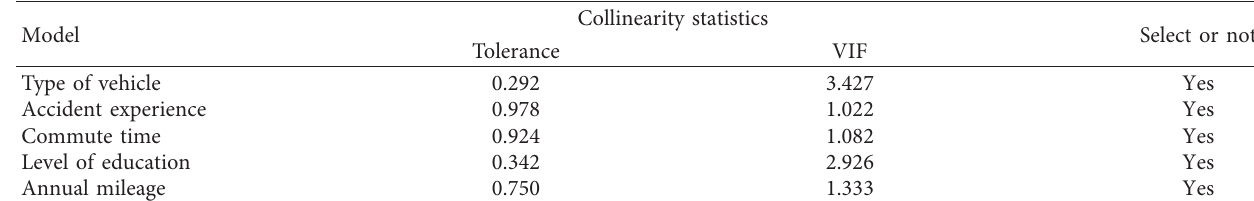
Table 4: Collinearity statistics of independent variables.